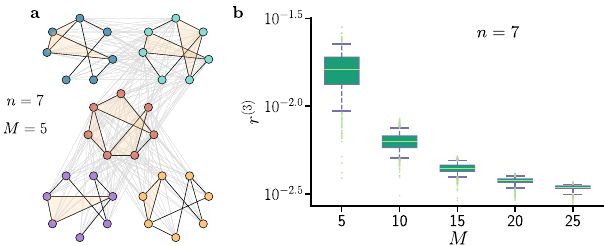
Fig. 3 Complexity reduction in the analysis of synchronization patterns in hypergraphs. a Example of a hypergraph consisting of M = 5 clusters, each with n = 7 nodes. Inside each cluster there are pairwise interactions (black lines) and three-body interactions (beige triangles). Two clusters are either all-to-all connected (gray lines) or fully disconnected. b Reduction in computational complexity achieved by the SBD algorithm for cluster size n = 7, intracluster link density p = 0.5, and intercluster link density q = 0.5 as the cluster number M is varied. The box covers the range 25th – 75th percentile, the whiskers mark the range 5th – 95th percentile, and the dots indicate the remaining 10% outliers. Each boxplot is based on